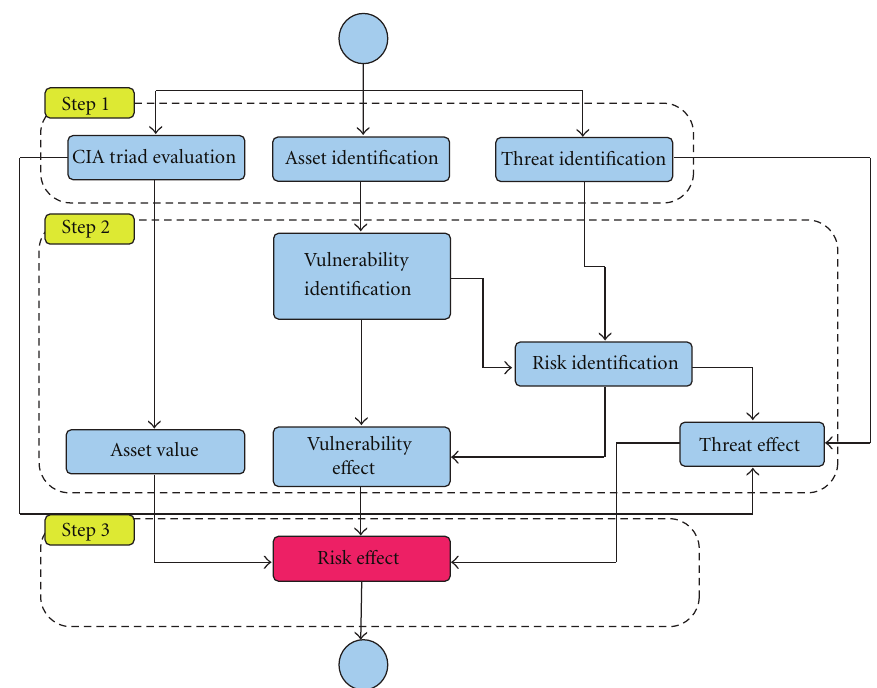
Figure 5: FEMRA risk assessment